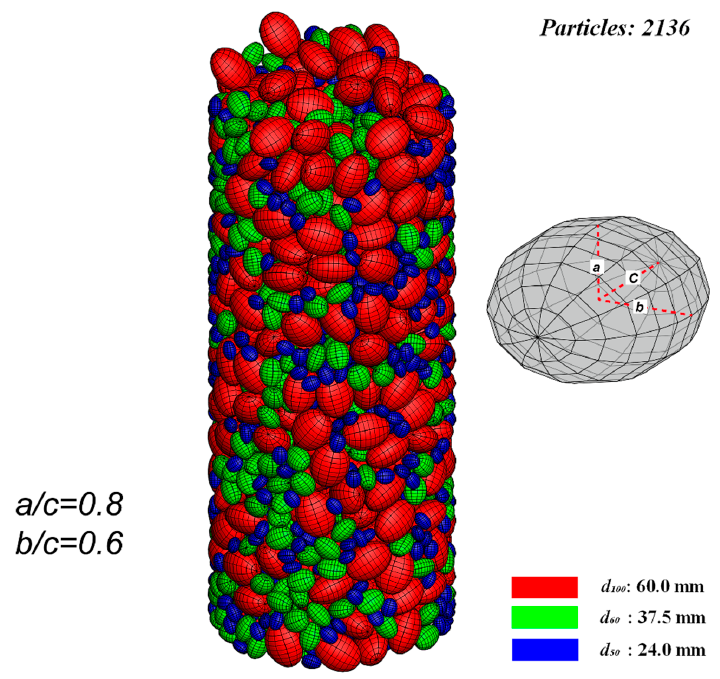
Figure 4. The cobble sample after deposition. Figure 6. The cobble sample after deposition.